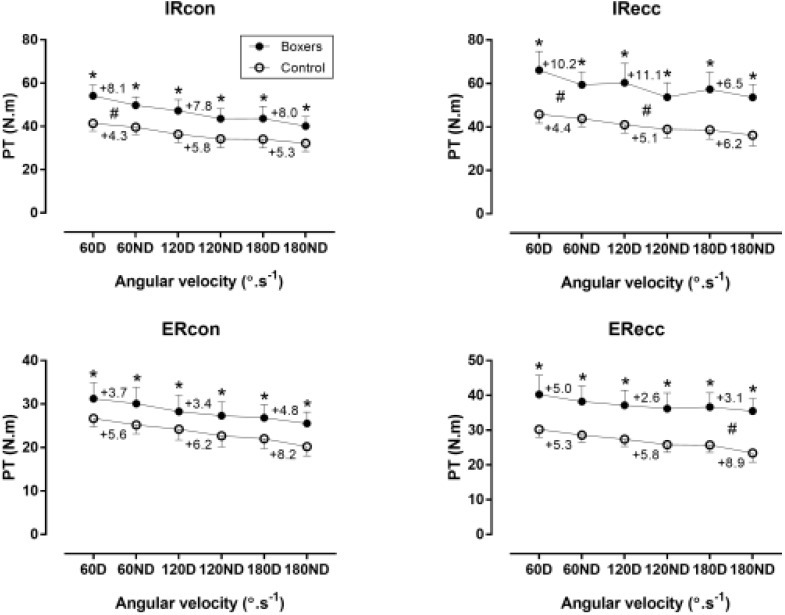
Peak torque (PT) of internal (IR), and external rotators (ER) of shoulder against 60, 120, and 180°/s in boxers and control group. ∗difference between boxers and control group at p < 0.05. D, dominant limb; ND, non-dominant limb. The numbers between D and ND points denote percentage differences between D and ND values. #limb × group interaction on peak torque at p < 0.05.